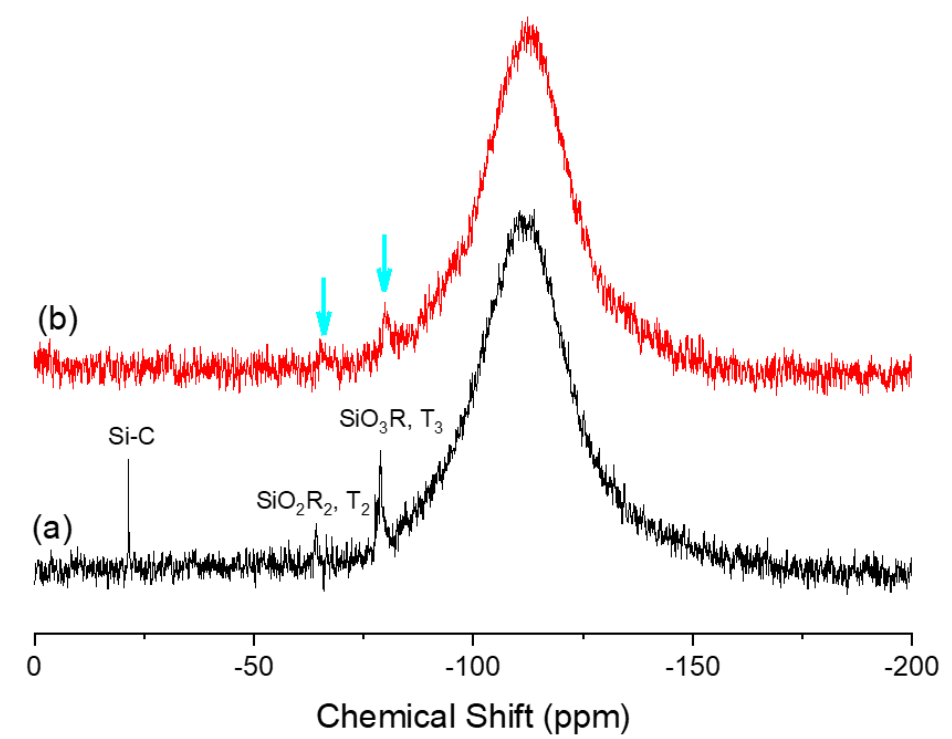
Figure 3. 29 Si NMR spectra of ( a ) DDSQ ‐ 4OH and ( b ) pure PDDSQ.